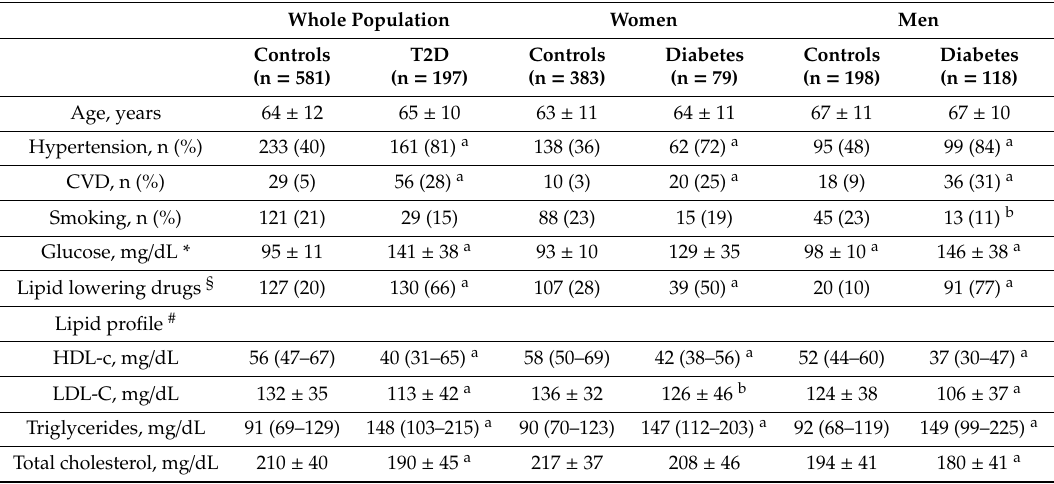
Table 1. Main clinical and demographic characteristics of controls and diabetic subjects in the whole population and divided by sex.